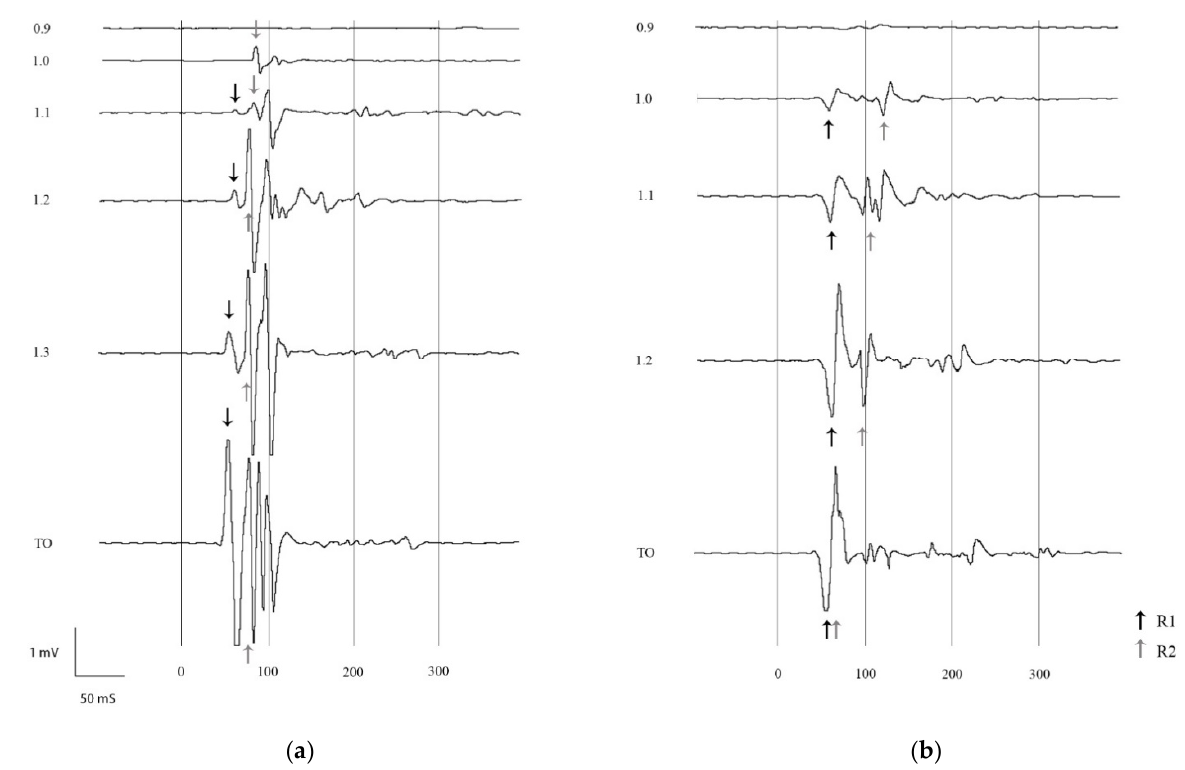
Figure 2. Electromyograms recorded from the right deltoid muscle after electrical stimulation of the right lateral palmar digital nerve in two horses ( a , b ). Stimulation intensity ranged from 0.9 times NWR threshold to NWR tolerance (TO), a stimulation accompanied by a reaction score of 5. Stimulation intensity was increased in steps of 10%. In the illustrations, the x -axis represents time (ms) and the y -axis represents amplitude (mV). Stimulation onset was at time 0. Where present, R1 is marked with black arrows and R2 with gray arrows. ( a ) The deflection from baseline seen at NWR threshold is R2. In the recording at 1.1 times NWR threshold R1 is preceding R2. R1 and R2 can be distinguished in all recordings, but they become closer for increased stimulation intensity, due to a shortening in the latency of R2. ( b ) At NWR threshold, R1 and R2 can be distinguished from each other, whereas at NWR tolerance only one reflex burst can be observed.